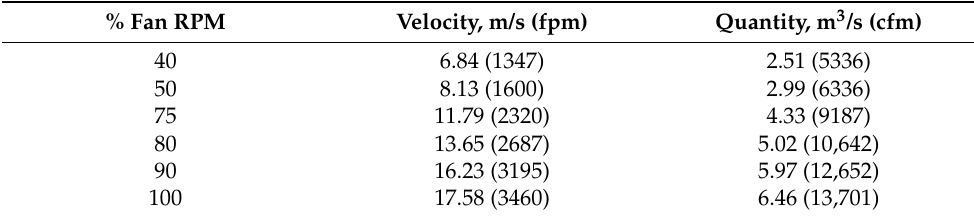
Table 1. Air quantity through scrubber at different fan speeds.